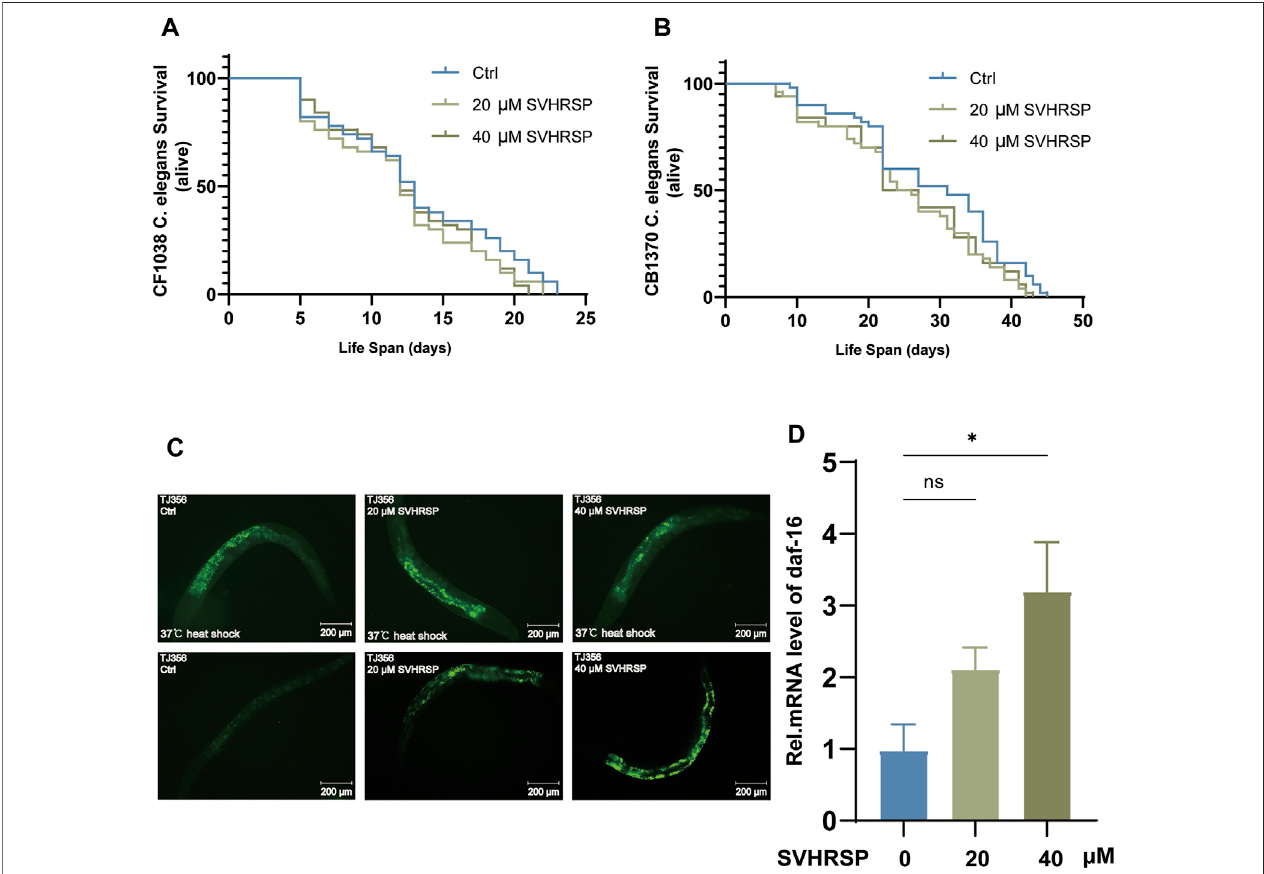
FIGURE 3 | Scorpion venom heat – resistant synthesized peptide (SVHRSP)-mediated longevity effects depended on the insulin/IGF-1-like signal (IIS) pathway. (A) effects of 20- and 40- μ M SVHRSP untreated treatments on the lifespan of CF1038 nematodes. (B) effects of 20- and 40- μ M SVHRSP treatments on the lifespan of CB1370 nematodes. (C) Fluorescence images of TJ356 nematodes treated with 20- μ M and 40- μ M SVHRSP, and untreated under heat stress. (D) Daf-16 mRNA expression levels of wild-type nematodes treated with 20- and 40- μ M SVHRSP untreated. Values are presented as mean ± SEM. All of these measurements were made at least three times. Log-rank and one-way analysis of variance veri fi es the calculated p -value. ns means none signi fi cant; * p < 0.05; ** p < 0.01; *** p < 0.001.